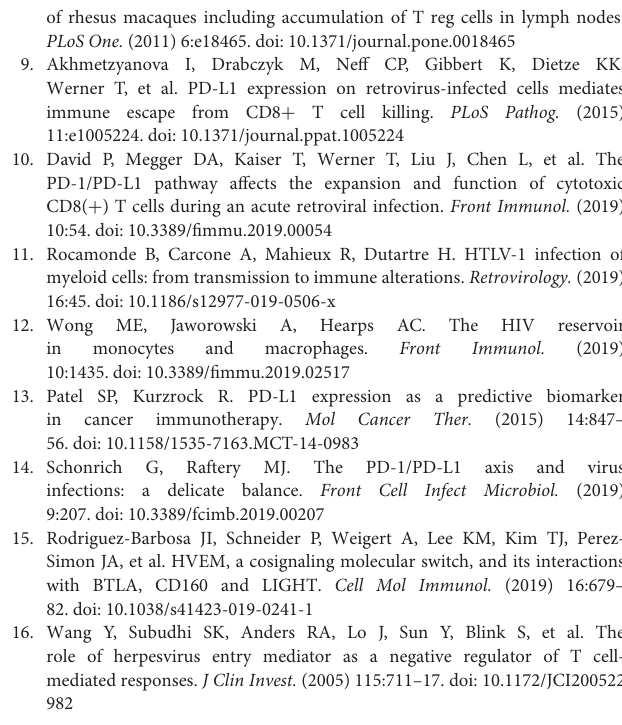
Supplementary Figure 4 | Expression of PD-L1 and HVEM on myeloid subpopulations after FV infection. C57BL/6 mice were infected with FV-mWasabi and splenocytes were isolated at day 10 after infection. Multi-parameter flow cytometry analysis was used to compare representative histograms for the MFI of PD-L1 (A) and HVEM (B) expression on the surface of infected (mWasabi + ; green), non-infected (mWasabi − ; red) and naive (day 0; blue) granulocytes (CD11b + Ly6C low Ly6G high ) monocytes (CD11b + Ly6C high Ly6G low ), macrophages CD11c + ). Supplementary Figure 5 | Expression of inhibitory receptors on virus-specific CD8 + T cells. C57BL/6 mice were infected with FV complex and splenocytes were isolated at different time points after infection. Representative contour plots show CD8 + T cells specific for the H-2Db–restricted Friend murine leukemia virus glyco-gag derived epitope GagL 85 − 93 (tetramer + ). Gated cells show the expression of the inhibitory receptors PD-1, BTLA, and CD160. Supplementary Figure 6 | Expression of PD-L1 and HVEM on HIV-1 infected human myeloid cells. Human PBMCs were stimulated with PHA and IL-2 prior to infection with HIV-1 and were analyzed on day 3, 5, and 7 after infection. Representative histograms show the expression of PD-L1 and HVEM on monocytes (A) and macrophages (B) . Supplementary Figure 7 | Mouse to mouse CD160 antibody (clone 6E7a) exhibits partial blocking activity of the HVEM/CD160 interaction. (A) Mouse CD160 transfected HEK293T cells were first incubated with anti-mouse CD160 mAbs, then unbound antibody was washed out and an optimal concentration of either mouse HVEM.Ig (1 mg/ml) or isotype-matched control (mouse IgG2a) was added to the reaction and incubated for 1h at room temperature. The reaction was developed using a biotinylated rat anti-mouse IgG2a monoclonal antibody for 1h at room temperature and streptavidin-PE. (B) The fluorescence histograms and MFI values show the partial inhibition of HVEM.Ig binding to CD160 transfected HEK293T cells in the presence of anti-mouse CD160